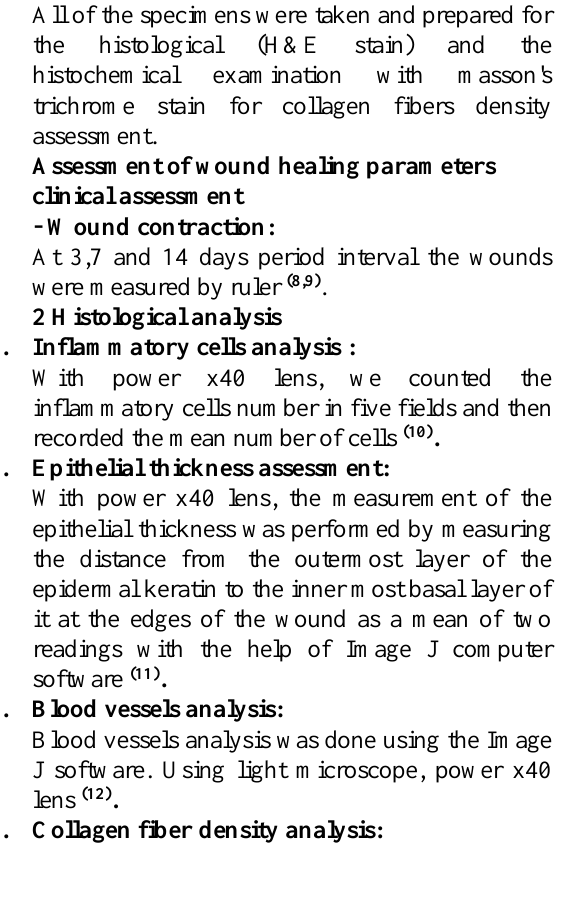
Table 1: Descriptive statistics of wound contraction at different healing period